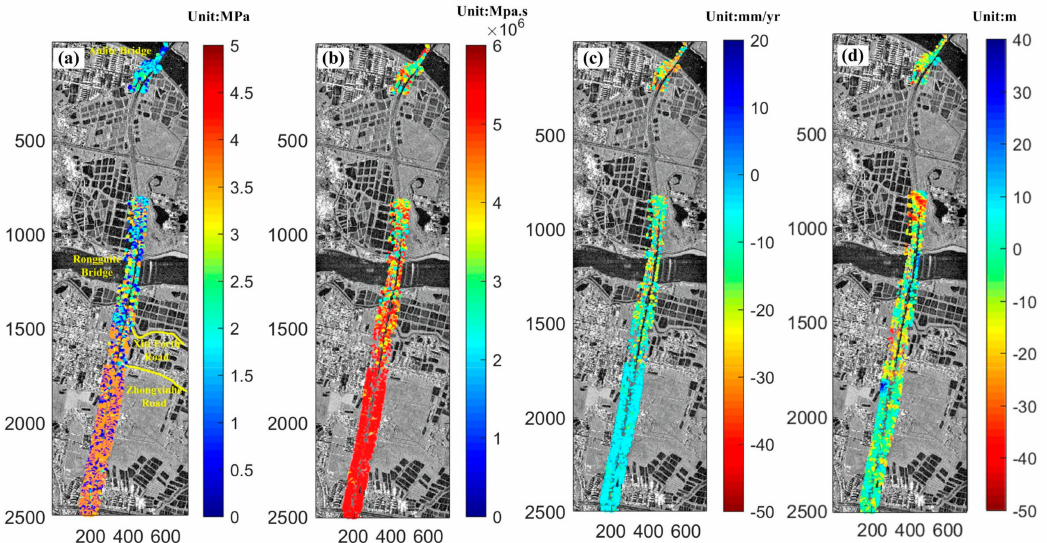
Figure 8. Estimated model parameters: ( a ) elasticity, E; ( b ) viscocity, η ; ( c ): linear velocity, v ; and ( d ) height correction, ∆